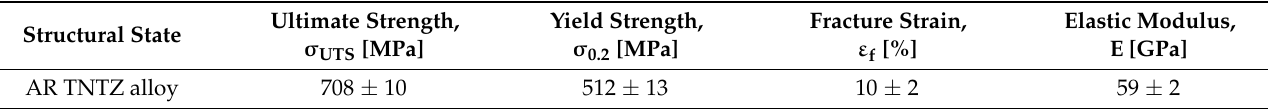
Table 2. Mechanical characteristics of TNTZ alloy in AR state. Figure 5. Grain-size distribution in AR TNTZ alloy.